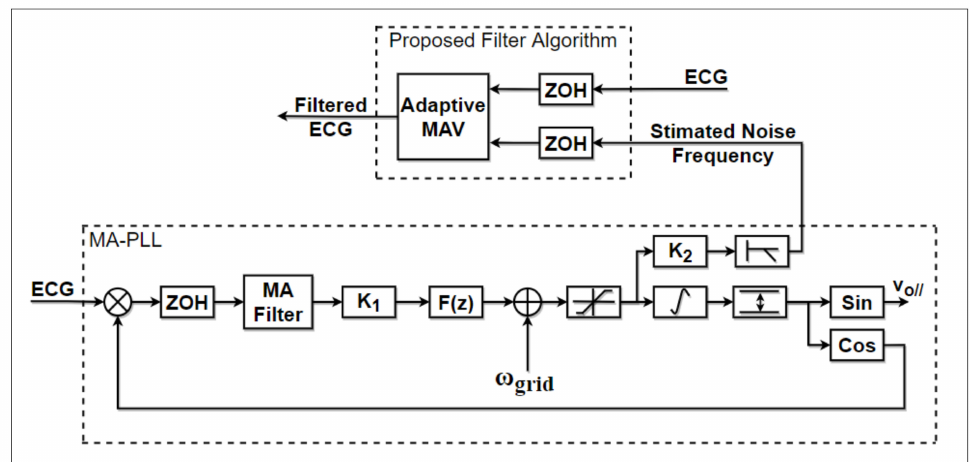
Figure 7. Block diagram of the 2MAV-PLL.